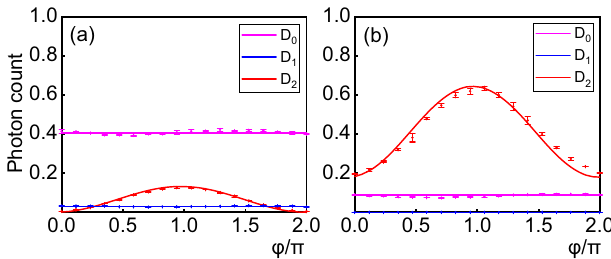
Fig. 4 Normalized photon counts at D0, D1, and D2. a tan2 θ a ¼ 0 : 38 , sin2 θ n ¼ 0 : 2 and ( b ) tan2 θ a ¼ 0 : 28 , sin2 θ n ¼ 0 : 9